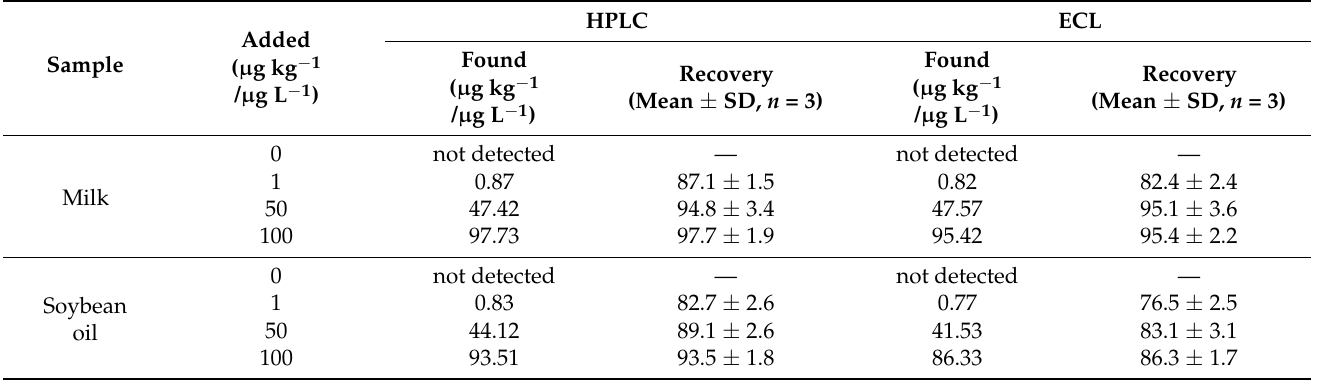
Table 1. Determination of carbaryl in food samples by the proposed ECL and